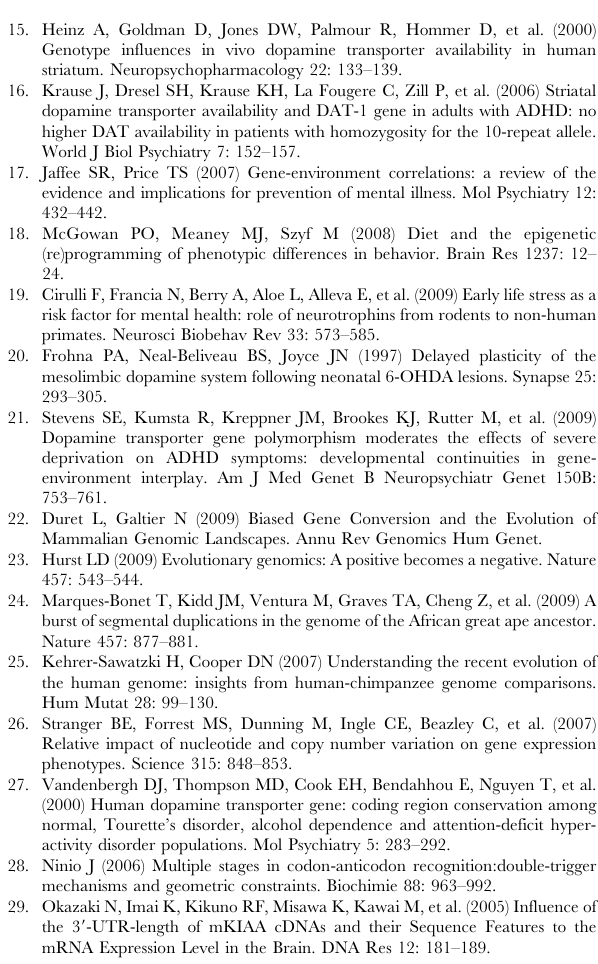
Figure S5 Experimental histone methylation data for the promoter region of the SLC6A3 and SLC6A4 genes. Compen- dium of these data is integrated in the UCSC genome browser, so, we retrieved the data on ‘‘active’’ histone modification mapped to the promoter regions of two genes. Histone profiling of the SLC6A3 (A) demonstrates lack of the acetylated histones and di- and tri-methylated H3K4 (green arrows), whereas the profile of the SLC6A4 regulatory region unequivocally reflects active status of the chromatin (red arrows) (B). Figure S6 Prediction of the promoter region using Core- Boost_HM. We used two algorithms of the program to assess differences in the promoter prediction that depend on the epigenetic sensitivity. A - For the SLC6A3, density scores calculated for CpG-related promoters (upper panel) display the highest peak overlapping with the putative TSS (red arrow). Calculation under the assumption of CpG-independent promoter fails to produce a peak near the canonical TSS; and the position of the dominant peak is shifted downstream (green arrow). B - similar analyses carried out for the SLC6A4 gene showed that the position of the predicted promoter remains the same when CpG-